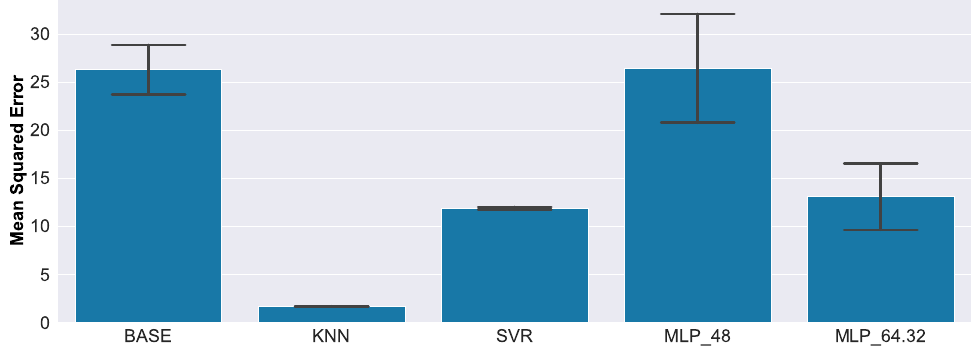
Figure 19. Regression results on real-world data. All methods except the baseline (BASE) and the smallest neural network (MLP_48) seemed to generalize reasonably well to unseen data.